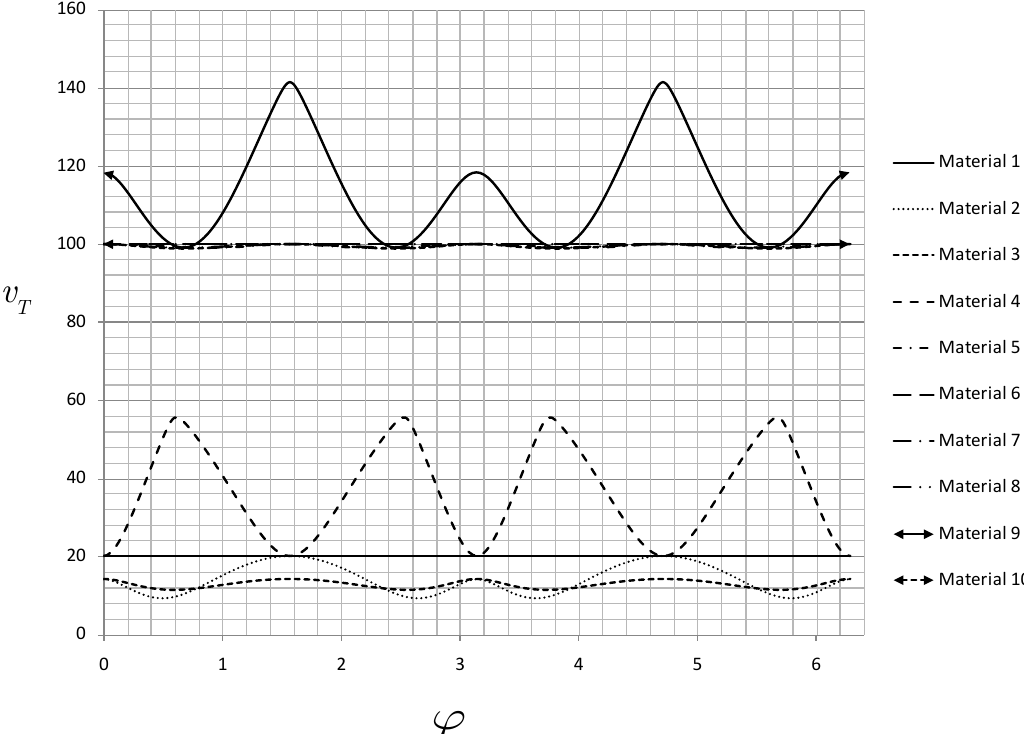
Fig. 4. Comparison of quasi-transverse wave velocity as a function of incident angle